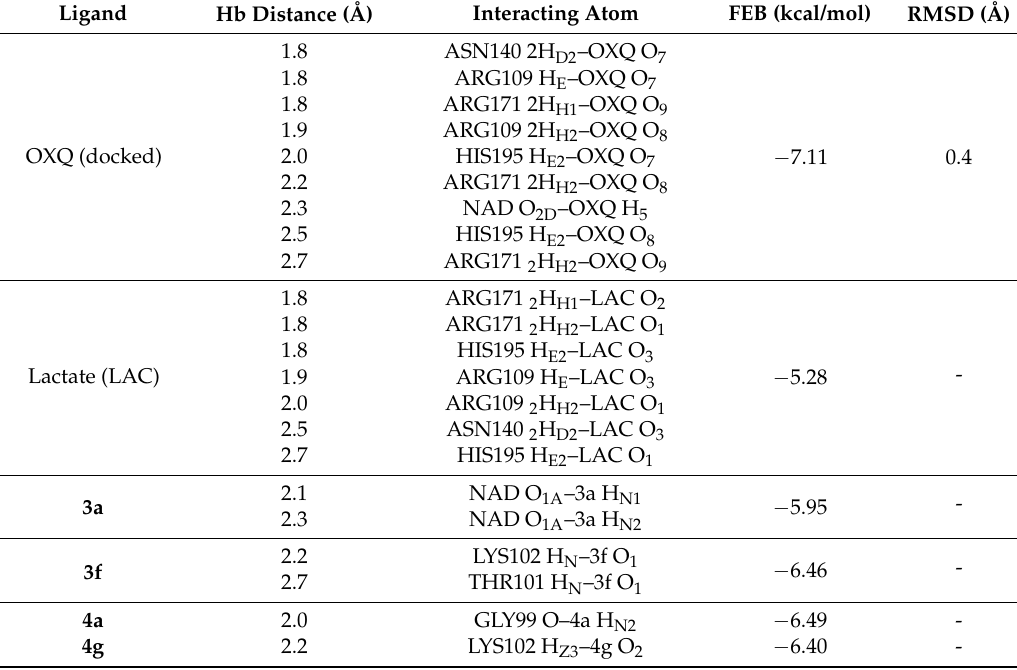
Table 3. Estimated binding free energy and hydrogen bond of ligands with parasite lactase dehydrogenase (pLDH) calculated from docking